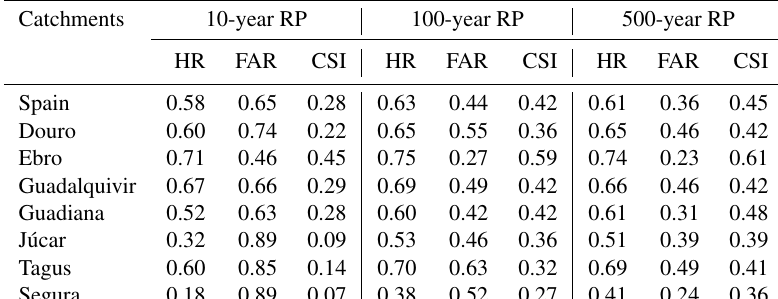
Table 5. Validation indices in Spain and in some test river basins.